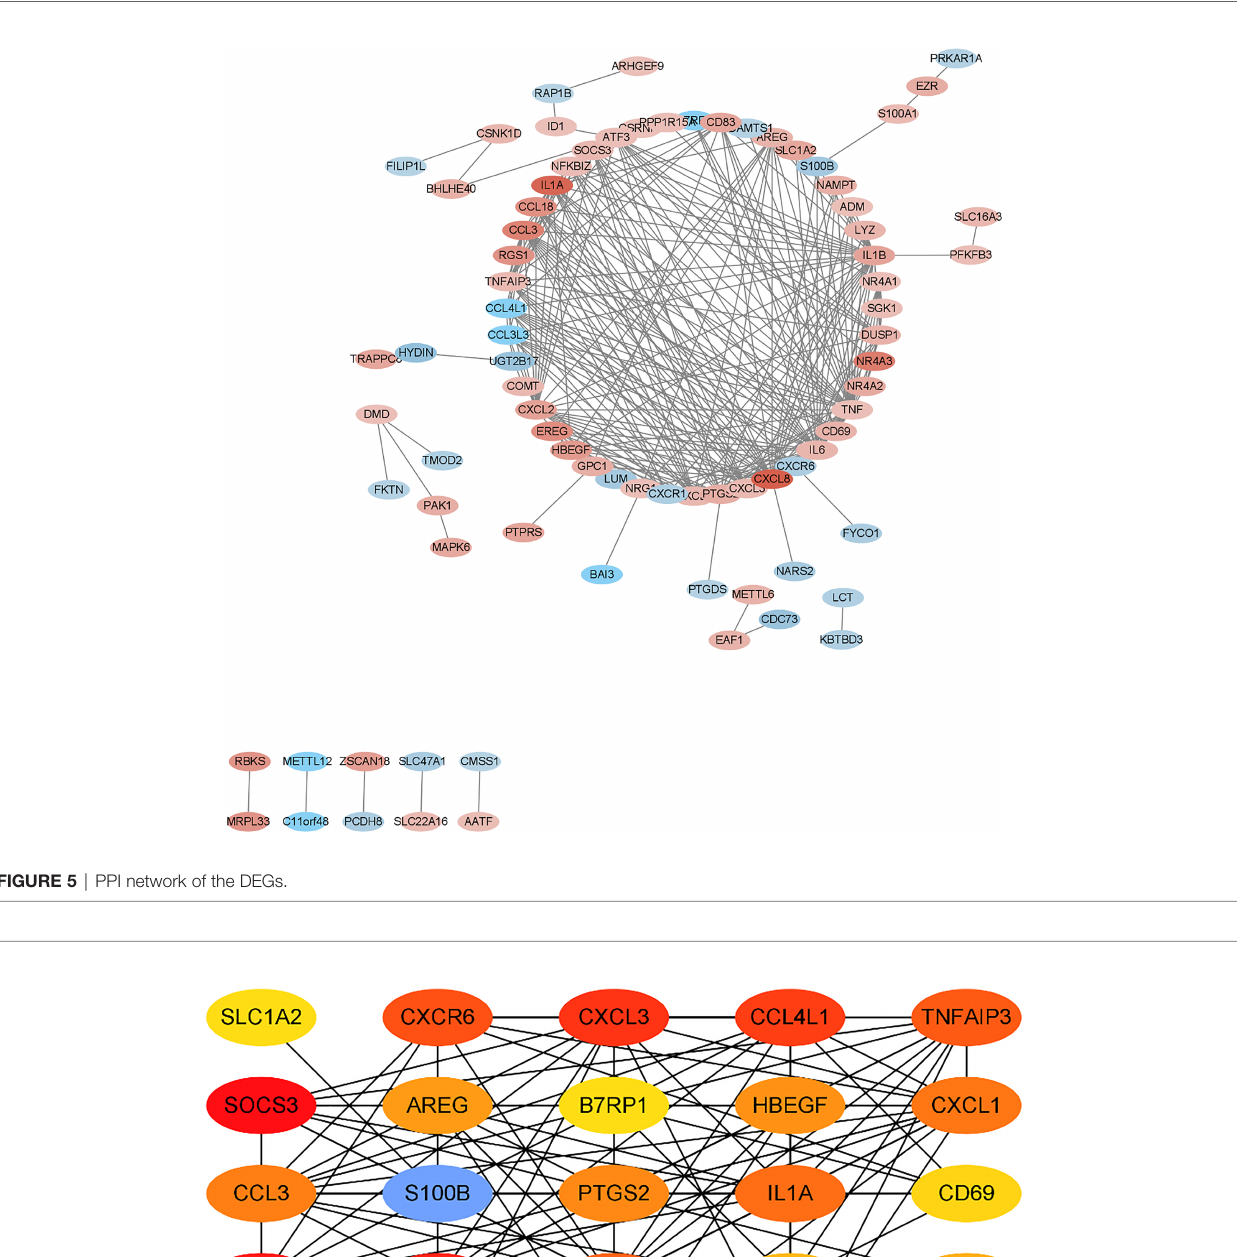
FIGURE 6 | Hub genes in the PPI network by